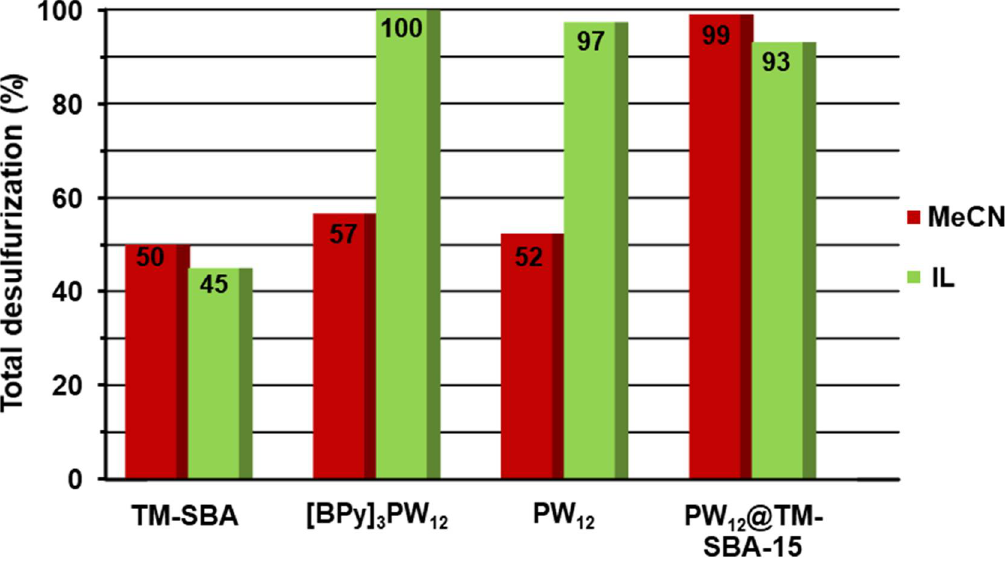
Figure 6. Desulfurization data of multicomponent model diesel obtained after 1 h in the presence of the support (TM–SBA), [BPy] 3 PW 12 , PW 12 and PW 12 @TM–SBA-15 with MeCN or IL ([BMIM]PF 6 ) as extraction solvent.